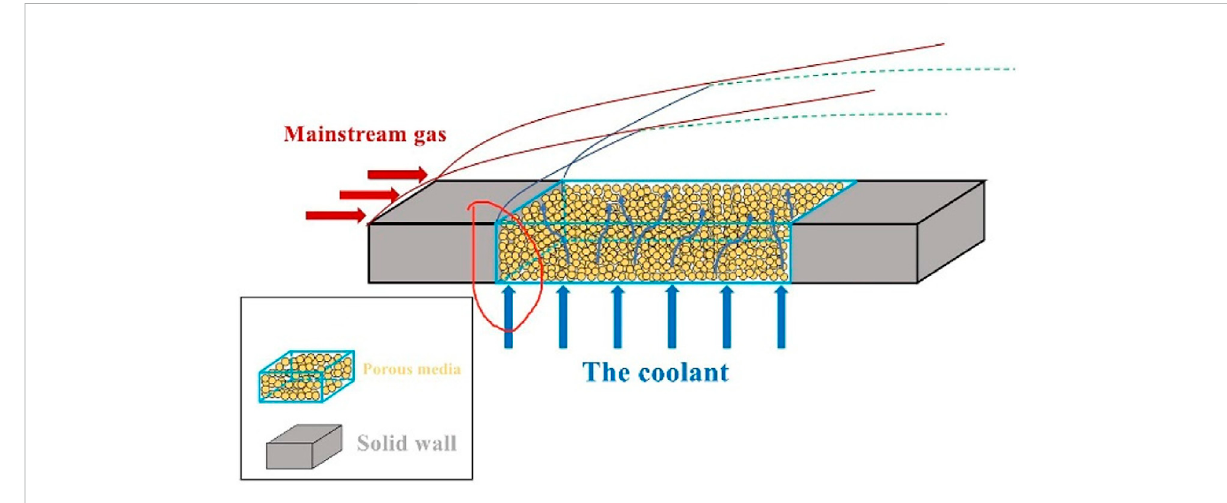
FIGURE 1 Schematic diagram of transpiration